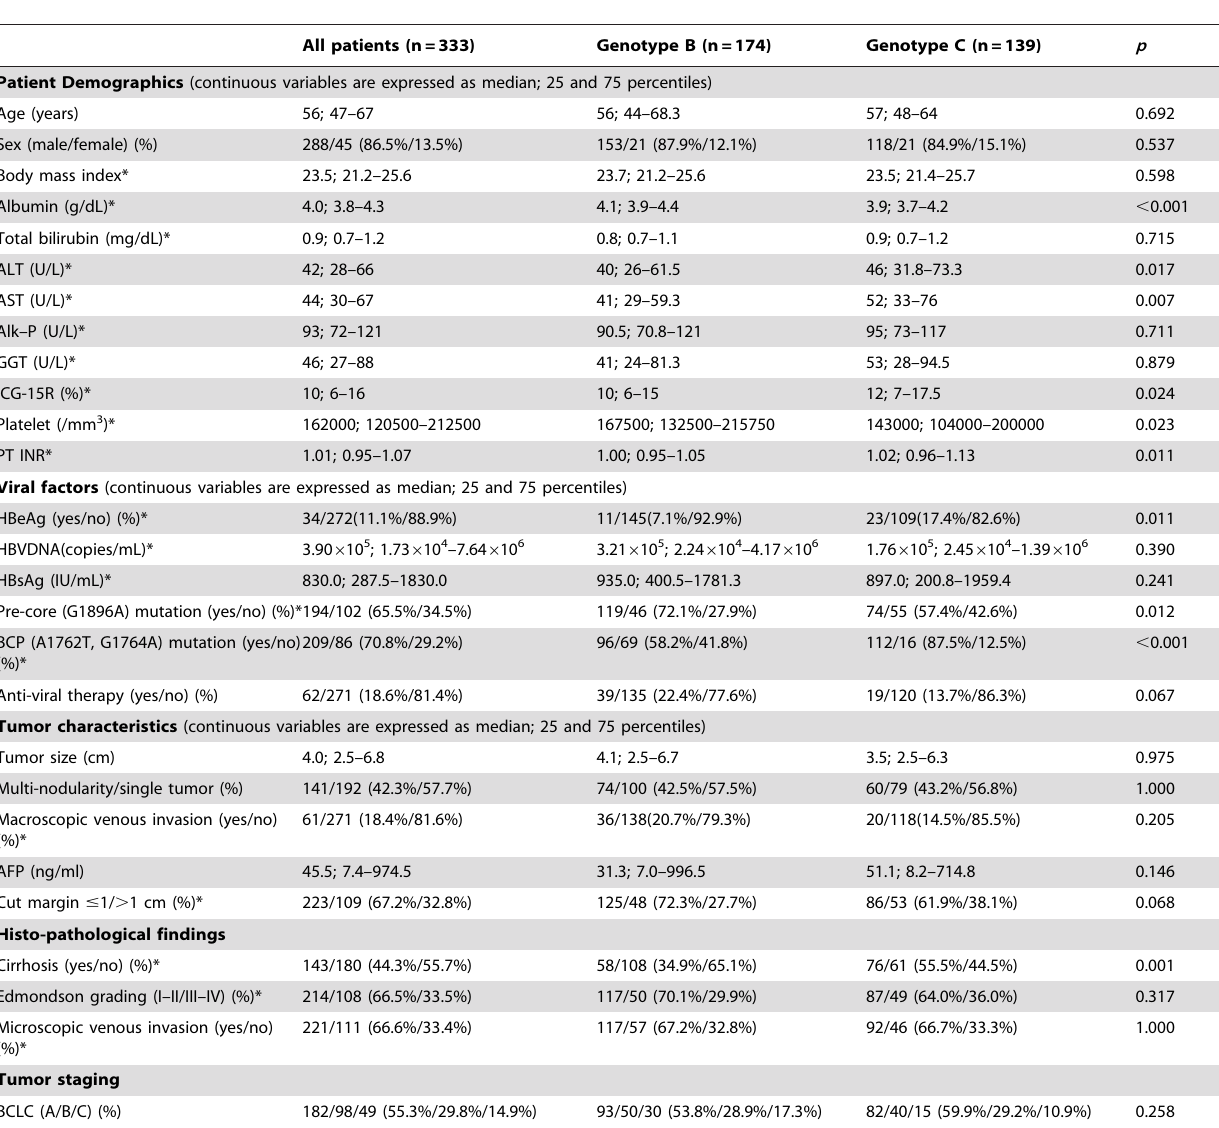
Table 1. Characteristics of HBV-induced HCC patients who underwent resection surgery.